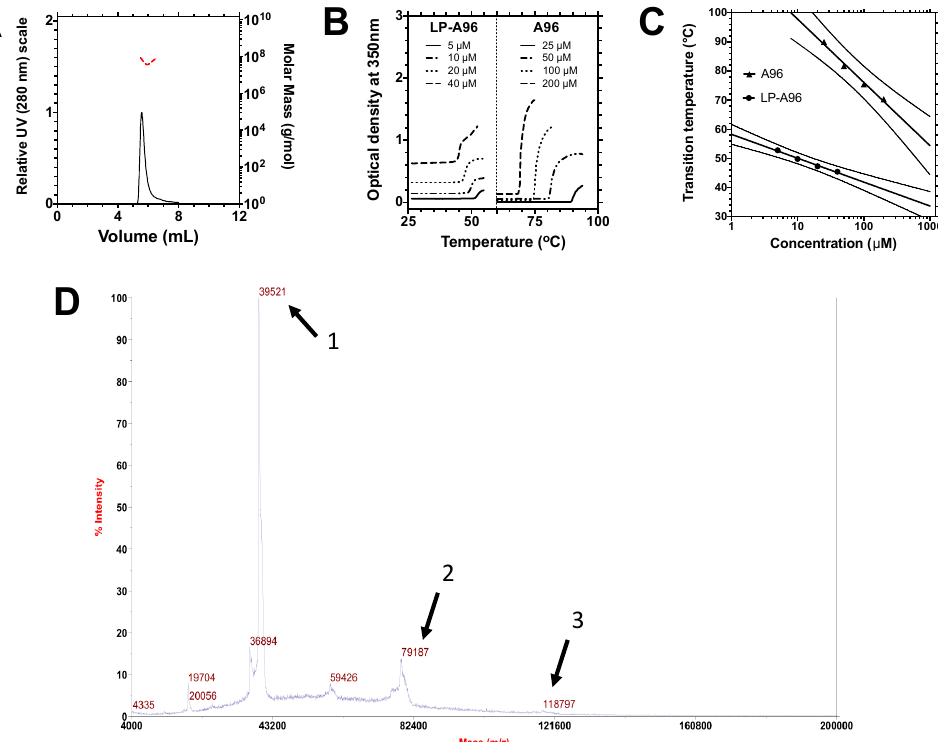
Figure A1. Biophysical characteristics of LP-A96. ( A ) LP-A96 elutes from size exclusion chromatography followed by multiangle light scattering (SEC-MALS) as a single peak (solid line according to left Y -axis) consistent with a nanoparticle with a radius of gyration of 79.3 nm (red dotted line according to the right Y -axis). ( B ) The ELP-mediated phase separation is monitored using optical density at 350 nm as a function of temperature using UV–Vis spectrophotometry (10 μ M in dPBS). ELP phase separation increases the optical density. Transition temperatures were identified using Equation (4). ( C ) A log-linear relationship between transition temperature and concentration was fit using Equation (3). Parameters of the fit are reported in Table A1. Dotted lines indicate 95% CI. ( D ) MALDI-TOF-MS analysis of LP-A96. The molecular weight of 39,521 Da (black arrow 1) is consistent with expected molecular weight reported in Table 1. Minor species identified at 79,187 Da (black arrow 2) and 118,797 Da (black arrow 3) are consistent with the masses expected for transglutaminase-mediated dimers and timers of LP-A96 [8]. Table A1. Parameters of LP-A96 and A96 phase separation.